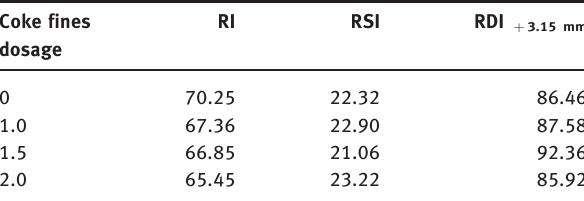
Table 4: Effect of coke fines dosage on metallurgical performances of fired